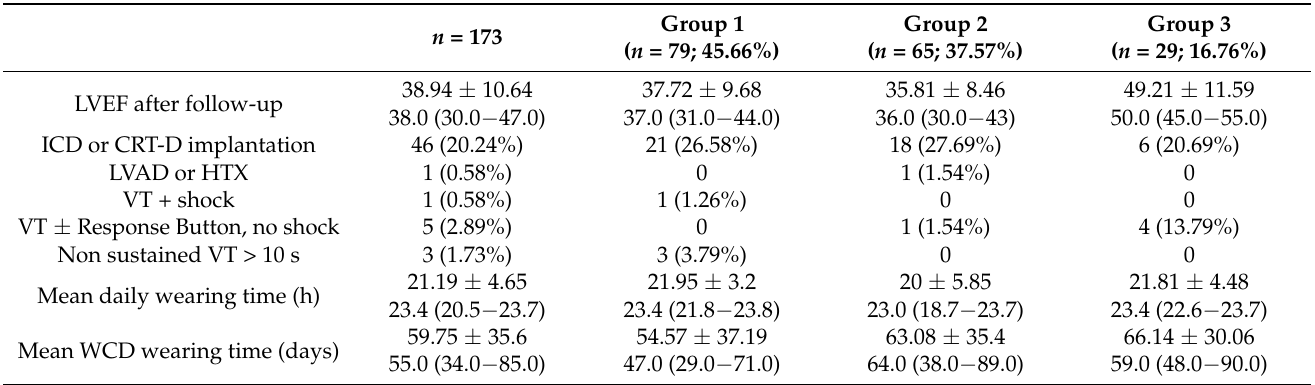
Figure 1. Compliance of different age groups. ◦ = individual patient data. Table 3. Follow-up, described by frequencies ( n , %) or mean and standard deviation (first line) and median and interquartile range (second line).